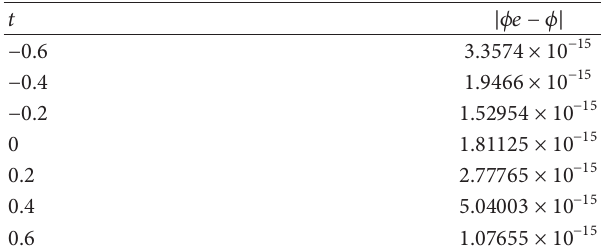
Table 2: The HPM results for 𝜙(𝑥,𝑦, 𝑡) in comparison with the analytical solution with initial conditions (5).